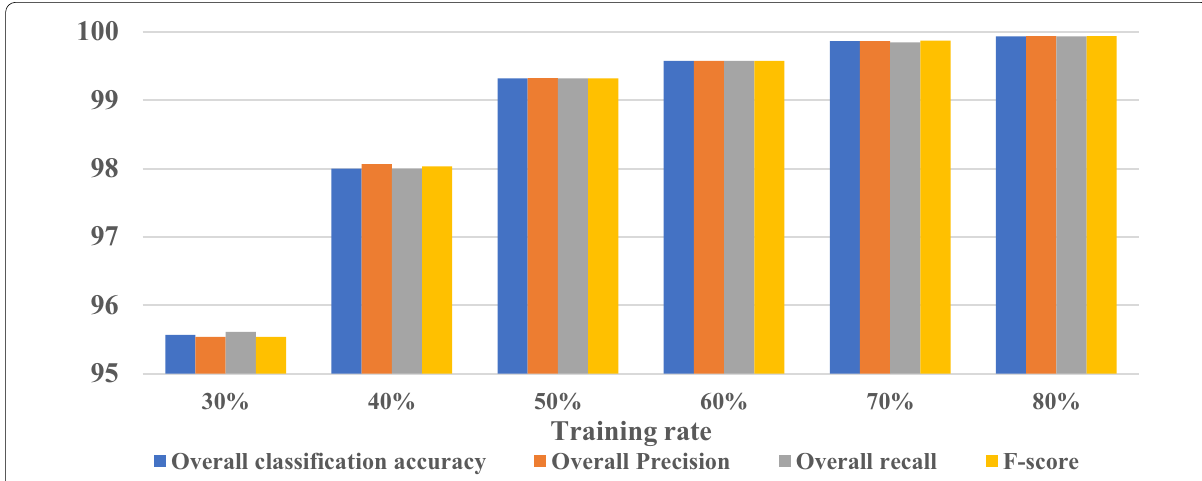
Figure 16 Overall classification accuracy, precision, recall, F-score results from dataset C of the second case study using the RGBVI-CNN method with 30% to 80% training size